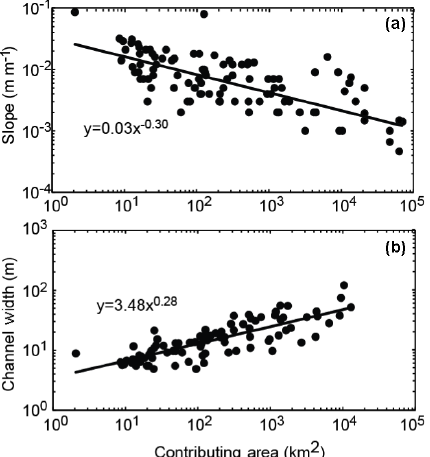
Figure 4. Power-law relationships between channel slope and con- tributing area (a) and channel width and contributing area (b) for the Colorado River